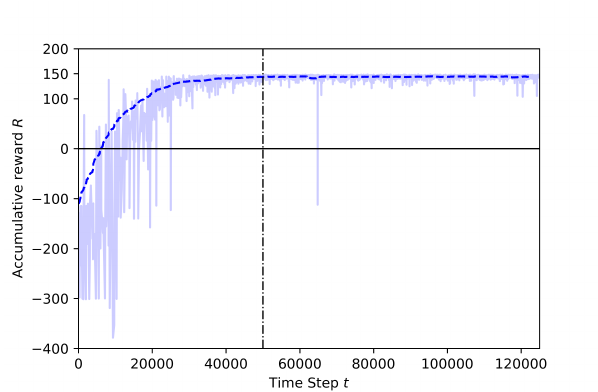
Figure 11. Training result for